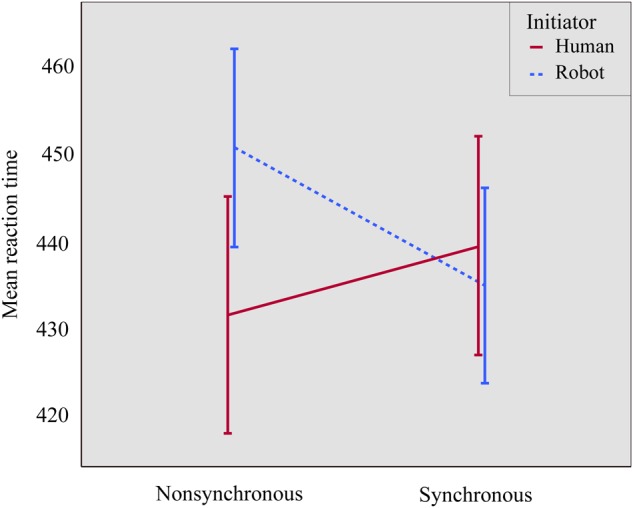
The effect of the interaction of synchrony and initiator on RT. Error bars represent standard errors. Participants in the human initiator group were faster in the non-synchronous compared to the synchronous condition (Msynchronous = 439, SDsynchronous = 11.9; Mnon-synchronous = 432, SDnon-synchronous = 12.6), whereas participants in the robot initiator group were faster in the synchronous compared to the non-synchronous condition (Msynchronous = 435, SDsynchronous = 12.2; Mnon-synchronous = 451, SDnon-synchronous = 12.8).